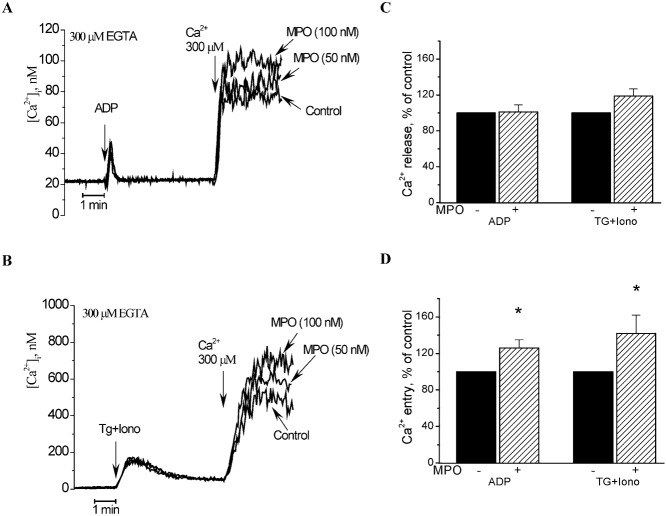
Effect of MPO on the activation of ADP- or TG+Iono-induced Ca2+ entry.(A) Fura-2-loaded platelets were incubated for 2 minutes at 37°C in the absence (control) or presence of different concentrations of MPO (50 and 100 nM) and then stimulated with ADP (1.3 µM) in a Ca2+-free medium (200 µM EGTA was added). 4 minutes later after addition of ADP CaCl2 (final concentration 300 µM) was then added to the medium of control or MPO-treated cells to initiate Ca2+ entry (activation of SOCE). Elevations in [Ca2+]i were monitored using the 340/380 nm ratio, and traces were calibrated in terms of [Ca2+]i. (B) Fura-2-loaded platelets were incubated for 2 minutes at 37°C in presence of catalase (300 units/ml) without (control) and with different concentrations of MPO (50 and 100 nM) and then stimulated with TG (1 µM) plus Iono (50 nM) in a Ca2+-free medium (200 µM EGTA was added). 4 minutes later after addition of TG plus Iono CaCl2 (final concentration 300 µM) was then added to the medium of control or MPO-treated cells to initiate Ca2+ entry (activation of SOCE). Elevations in [Ca2+]i were monitored using the 340/380 nm ratio, and traces were calibrated in terms of [Ca2+]i. (C,D) Histograms indicate the percentage of Ca2+ release and Ca2+ entry under the different experimental conditions relative to their control. Ca2+ entry was determined as described in Materials and Methods. Values are mean ± s.e.m. of three independent experiments. *P<0.05, n = 3.